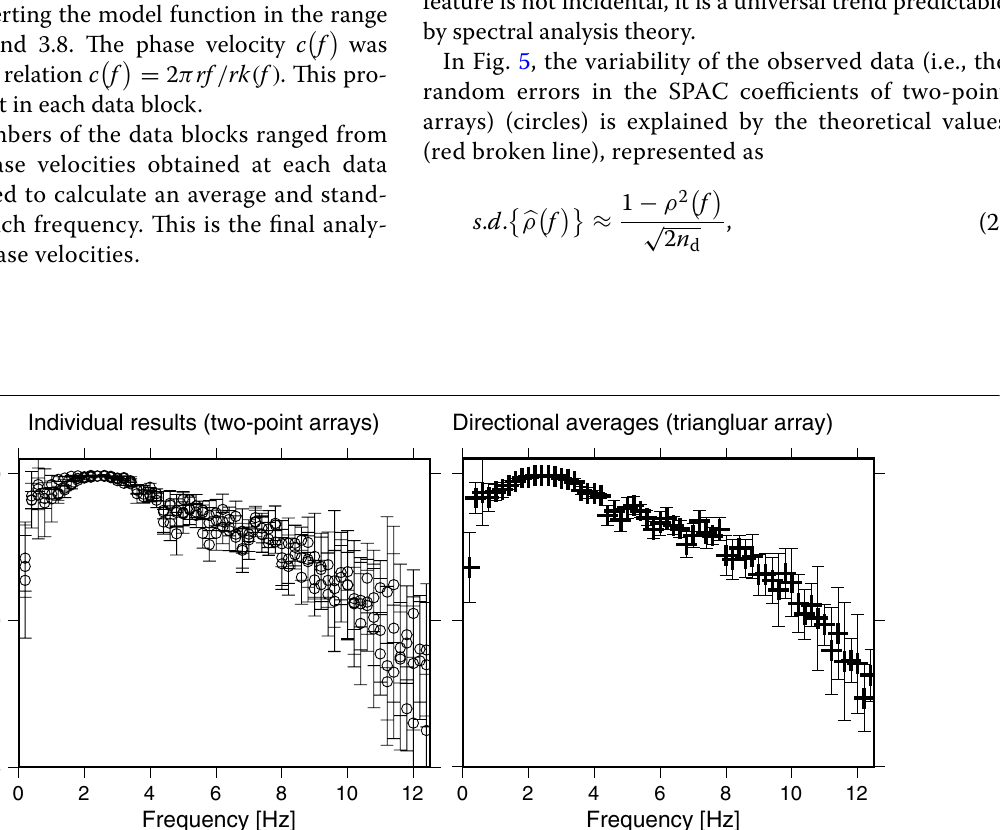
Fig. 4 SPAC coefficients obtained by analyzing array data with a radius of 0.58 m. Average values with error bars (standard deviations) are plotted. Individual analysis results of two-point arrays (real parts of the coherencies, circles) and the directional averages (triangular array, crosses) are plotted in the left and right panels,